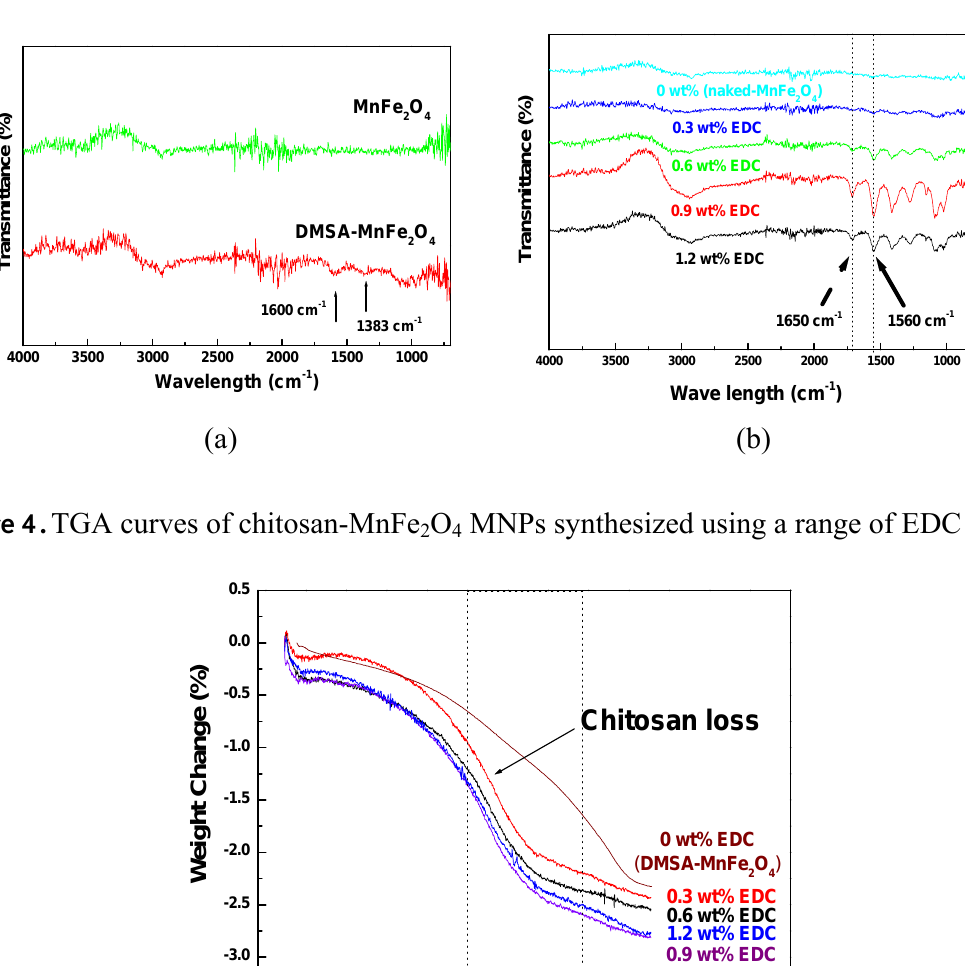
O and (b) chitosan-MnFe 2 4